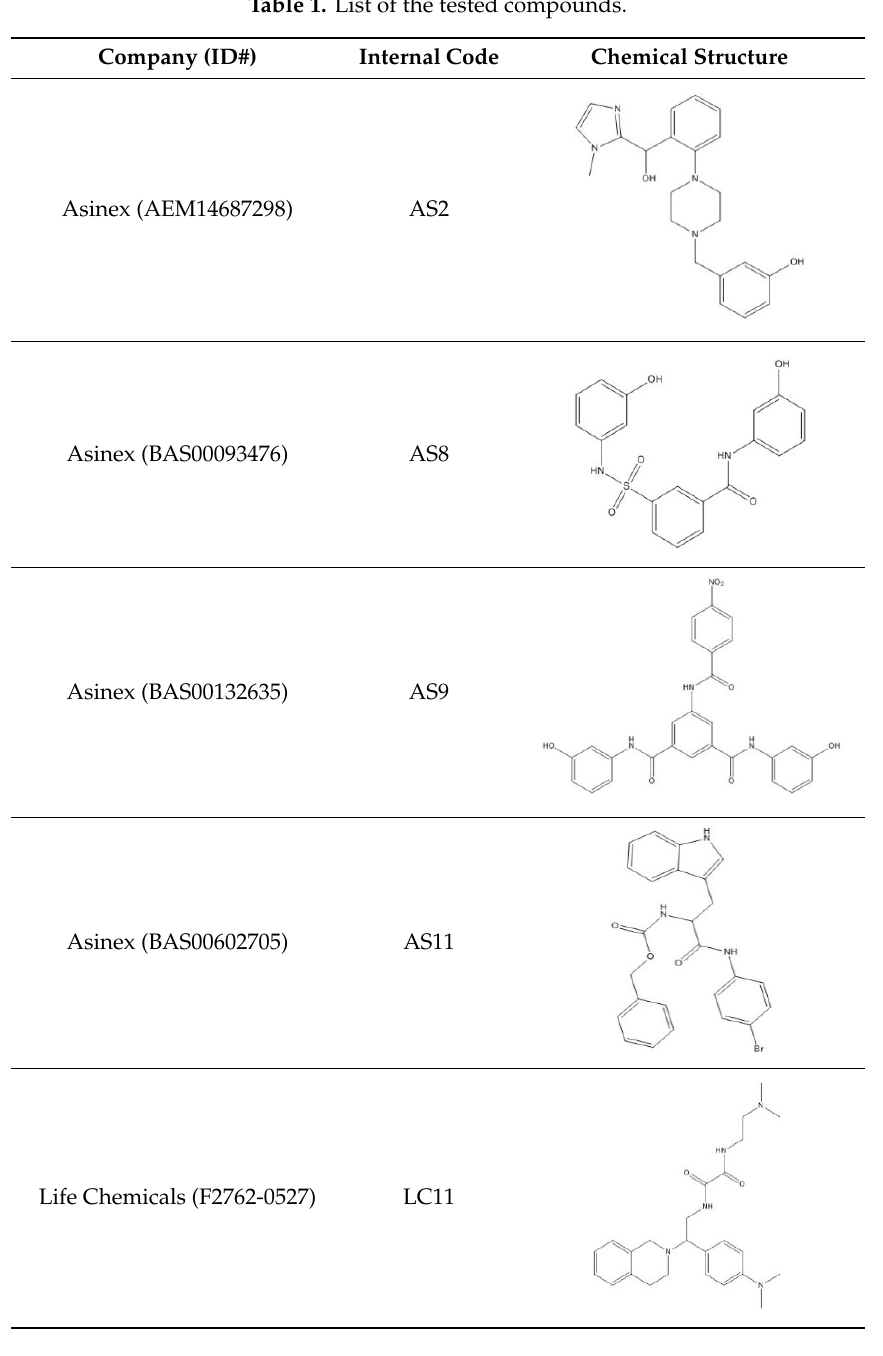
Table 1. List of the tested compounds.